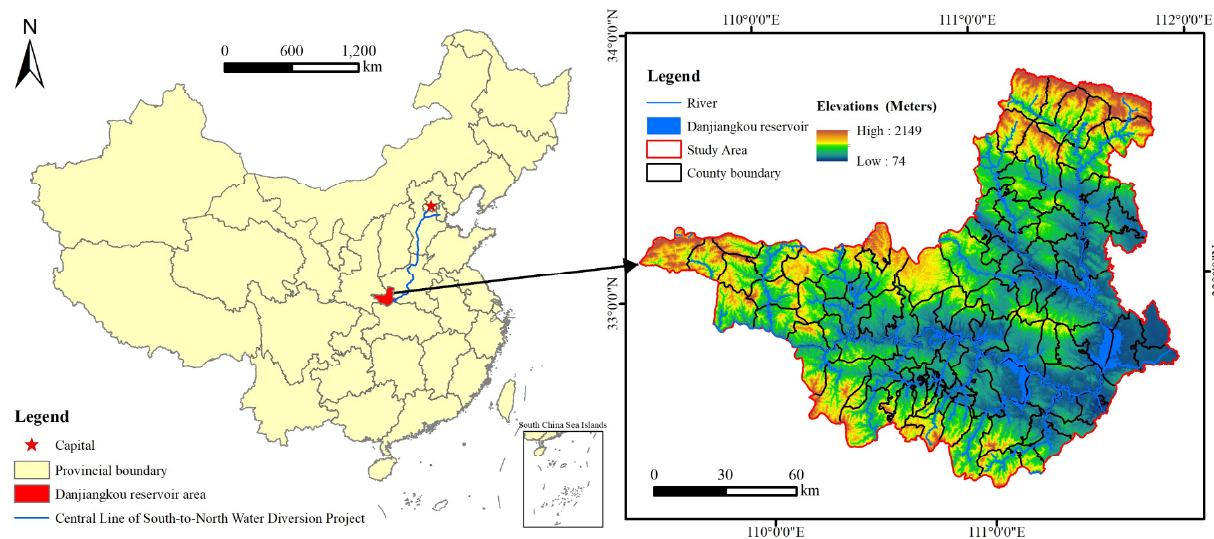
Figure 1. Geographic location of the Danjiangkou reservoir area and the Central Line of South-to- North Water Diversion Project.